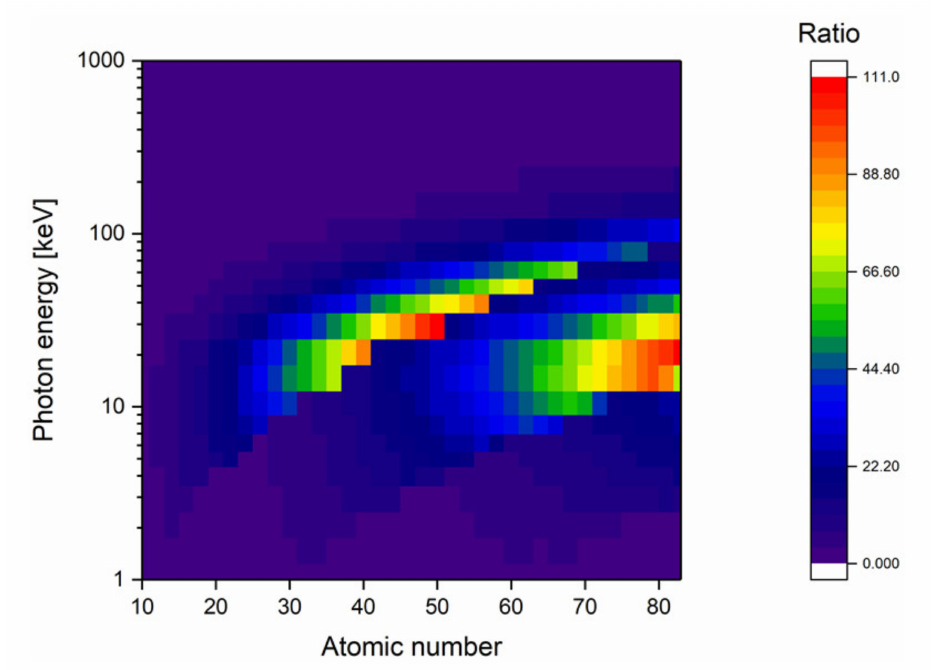
Figure 6. Comparison between photon absorption cross-section in water and in di ff erent materials. The ratio of absorption cross-section in a nanoparticle on absorption cross-section in water was plotted according to the incident photon energy and atomic number of the material of interest. Red areas indicate high dose deposition areas while purple ones correspond to no significant increase in photon